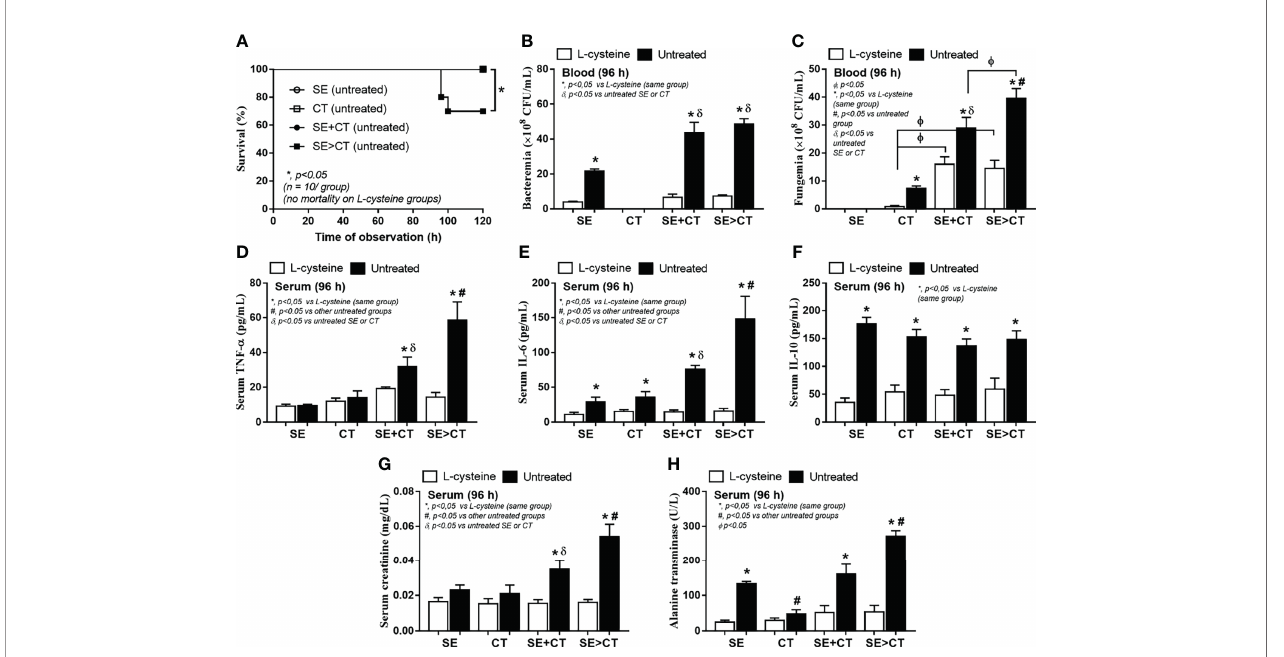
FIGURE 7 | Characteristics of mice with subcutaneously implanted bio fi lm catheters from Staphylococcus epidermidis (SE), Candida tropicalis (CT), SE simultaneously mixed with CT (SE + CT), and preformed SE bio fi lms following CT (SE > CT) as determined by survival analysis (A) , bacteremia and fungemia (B, C) , serum cytokines (TNF- a , IL-6, and IL-10) (D – F) , kidney injury (serum creatinine) (G) , and liver damage (alanine transaminase) (H) are demonstrated (n = 7 – 9/group for B – H ). *p < 0.05 was considered statistically signi fi cant in the same group whereas # p < 0.05 was those in the other